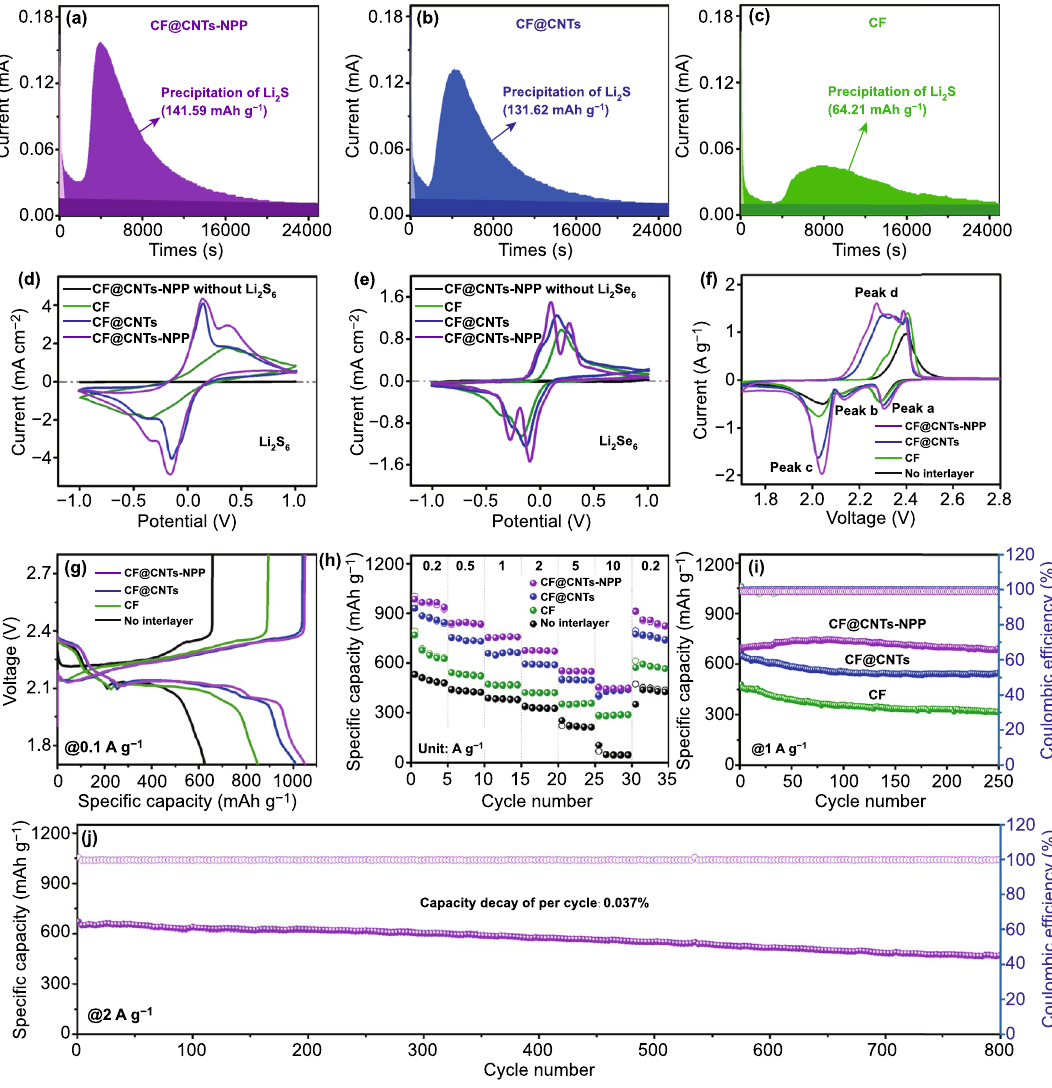
Fig. 4 Potentiostatic discharge profiles of cells with a CF@CNTs-NPP, b CF@CNTs and c CF at 2.05 V. CV curves of symmetric cells with different electrodes d with or without 0.2 M Li 2 S 6 and e with or without 0.2 M Li 2 Se 6 at the scan rate of 1 mV s −1 . f CV curves at the scan rate of 0.1 mV s −1 . g Initial discharge–charge curves at 0.1 A g −1 . h Rate capability. Cycling performance at i 1 A g −1 and j 2 A g −1 under room tem-